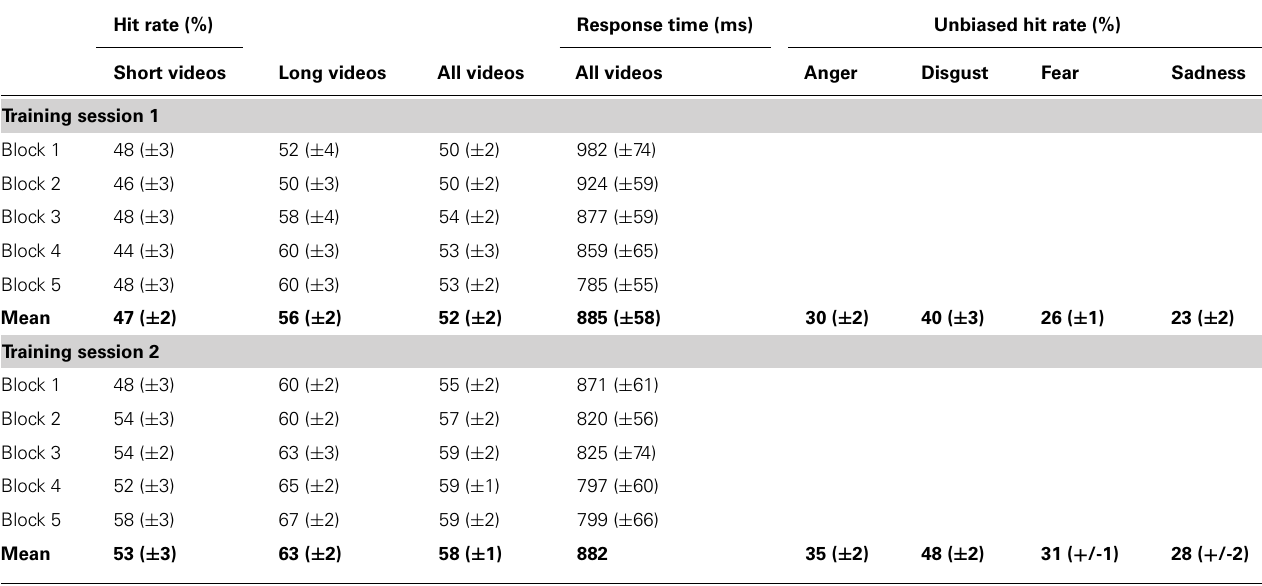
Table 1 | Mean hit rates, response times, and unbiased hit rates for all